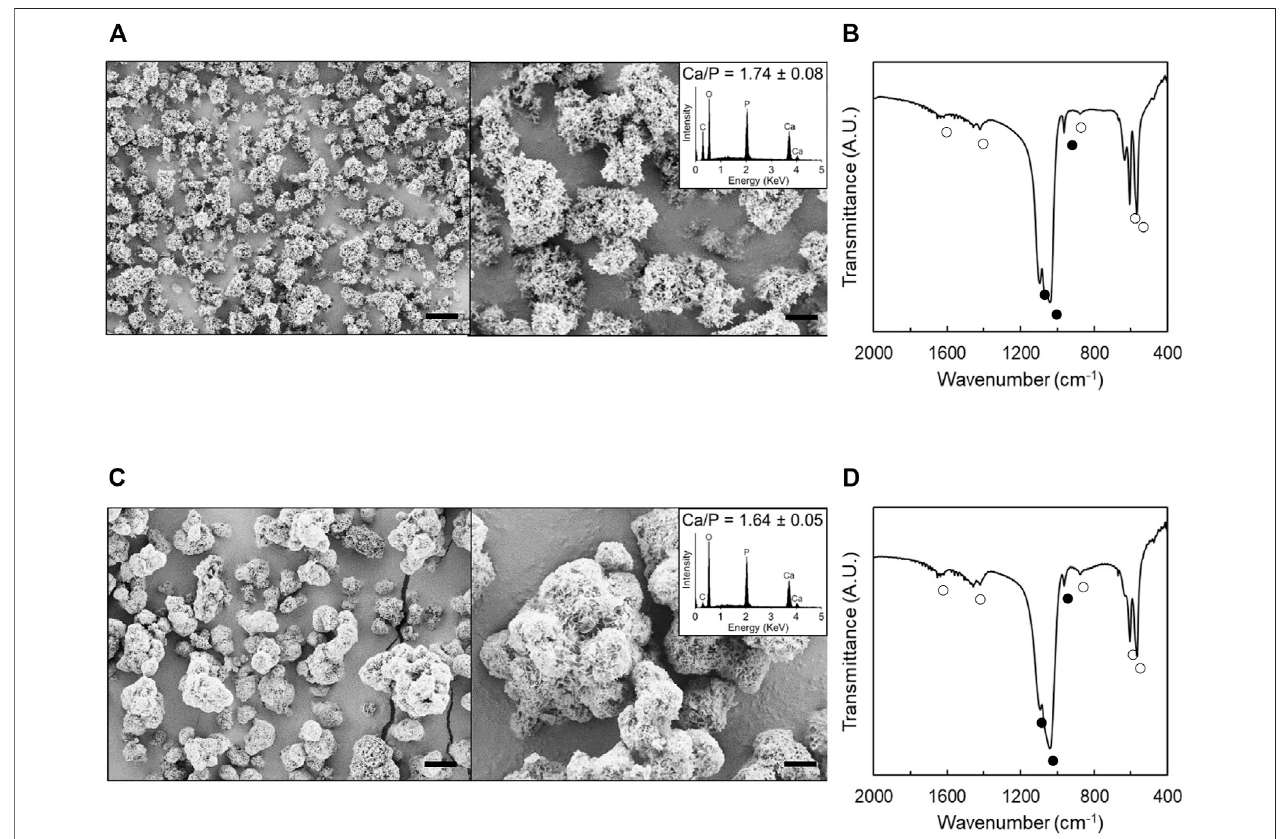
FIGURE 1 | Morphological and compositional analyses of hydroxyapatite particles and MCM. A, C: SEM images of hydroxyapatite particles (A) and MCM (C) . Insets show their EDS spectrum. B, D: FT-IR spectra of hydroxyapatite particles (B) and MCM (D) . C and ○ denote the peaks associated with phosphate and carbonate, respectively. Scale bars: 5 µm (left images) and 2 µm (right